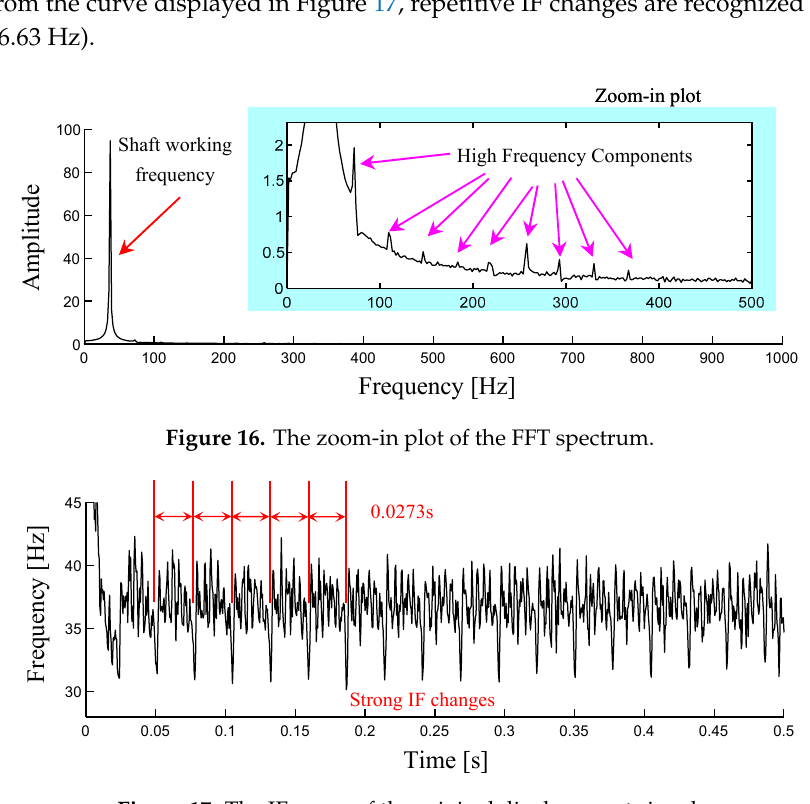
Figure 17. The IF curve of the original displacement signal.